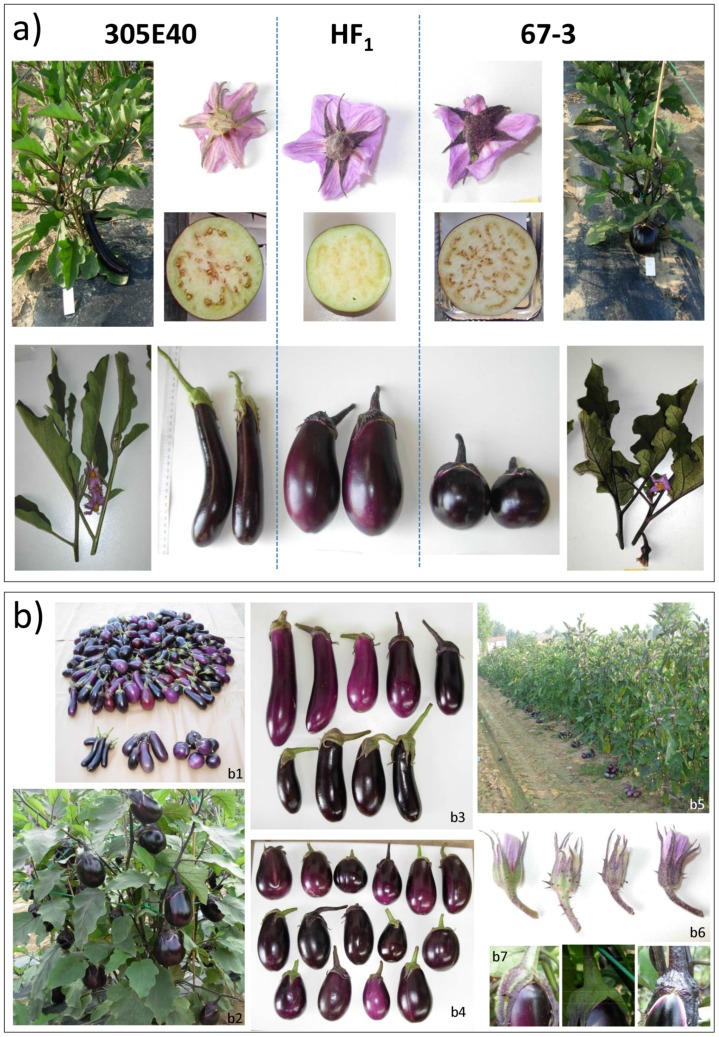
Parental and F2 progeny phenotypes for some of the traits considered.a) Morphological features of the parental lines 305E40 and 67/3, and of the hybrid F1. For each parental lines are shown: whole plant where the different growth habit can be appreciated, a detail of the principal apical shoot with leaves and flowers (where also multiple inflorescence in 305E40 and single flower/inflorescence in 67/3 can be noted), fruits (where colour, dimensions, peduncle length and prickles can be noted), a section of the fruit (where the green ring and number of seed locules can be distinguished) and a flower (presence/absence of prickles). For the hybrid, flower, fruit and fruit section are shown. b) Some morphological features of the segregating F2 progenies. b1: an overview of fruit diversity among the entire progeny with respect to the parental lines (from the left: 305E40, HF1, 67/3); b2: detail of an F2 plant during the harvesting season: the abundance of fruits of this genotype overcome the parental lines (one of the transgressive genotype for yield); b3 and b4: detail of fruit produced by different F2 plants showing variability for colour, dimensions, shape, calyx prickles and peduncle length roughly grouped according to the long (b3) and oval (b4) typologies; b5: a view of F2 field-grown plants after an harvesting; b6: flowers differing for colour and presence of prickles; b7: example of some fruit calyxes differing for colour and presence of prickles.